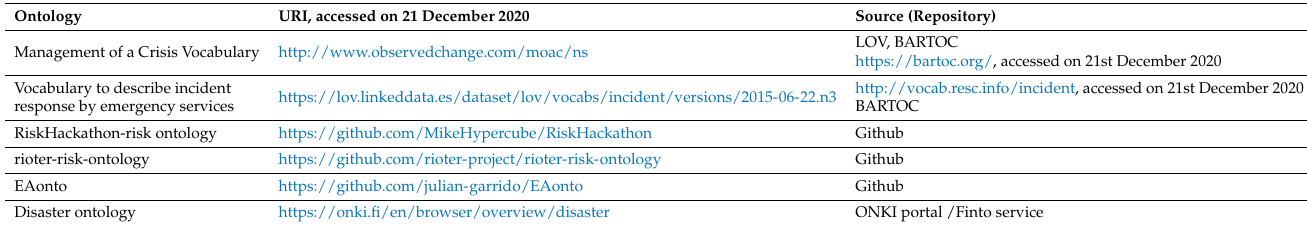
Table 8. Ontologies Extracted from Repository